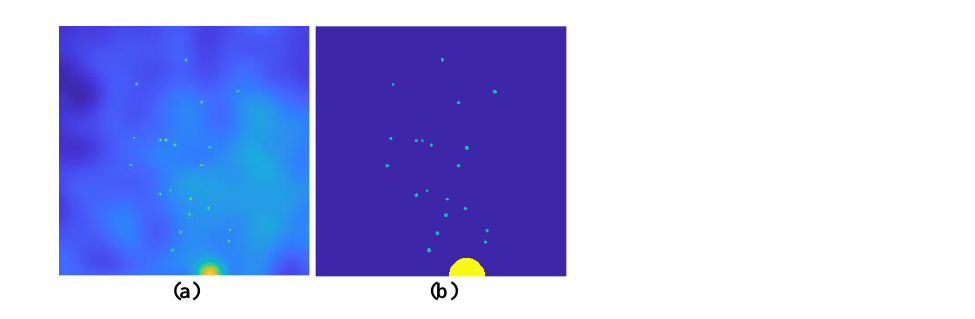
Figure 6. Simulation data, labeled foreground cluster region and sparse spots. ( a ) is simulated data; ( b ) is labeled foreground and sparse spots. Table 1. The Precision of the decomposition result is based on the proposed HTD